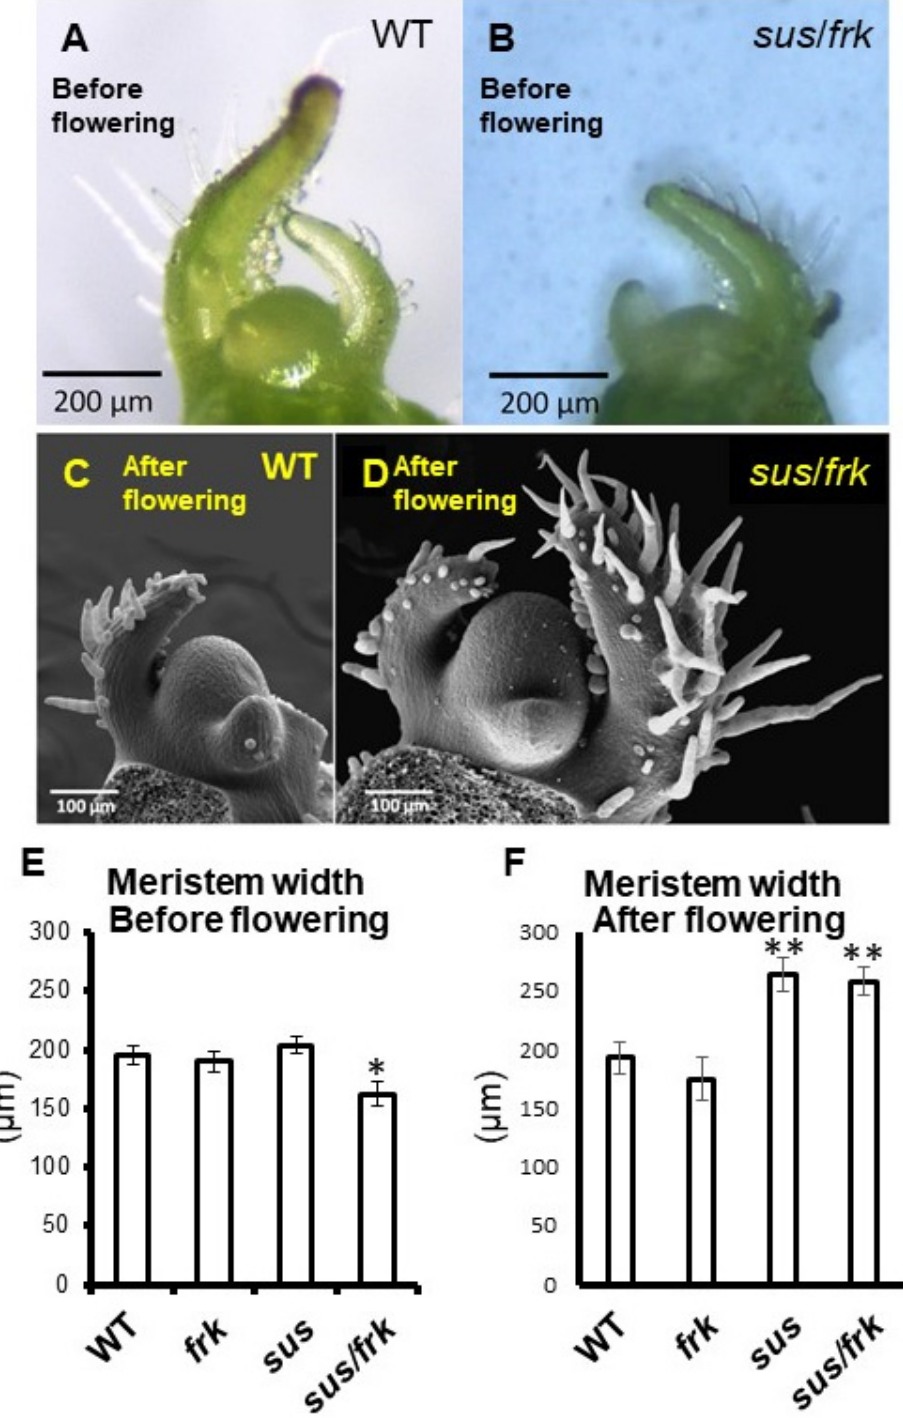
Figure 9. At an early vegetative phase, the SAMs of sus / frk are narrower than WT SAMs, but the SAMs of sus / frk and sus are larger after the transition to flowering. ( A ) Early vegetative SAM of a WT seedling. ( B ) Early vegetative SAM of a sus / frk seedling. ( C ) WT apical meristem (sympodial shoot meristem) after the transition to flowering and ( D ) sus / frk apical meristem after the transition to flowering. ( E ) Widths of the early vegetative SAMs of frk , sus and sus / frk , as compared to the WT. Data points are means ± SE ( n ≥ 4). ( F ) Widths of the SAMs of frk , sus and sus / frk , as compared to those of the WT after the transition to flowering. Data points are means ± SE ( n = 5). An asterisk indicates a significant difference relative to the WT (* p < 0.05; ** p <